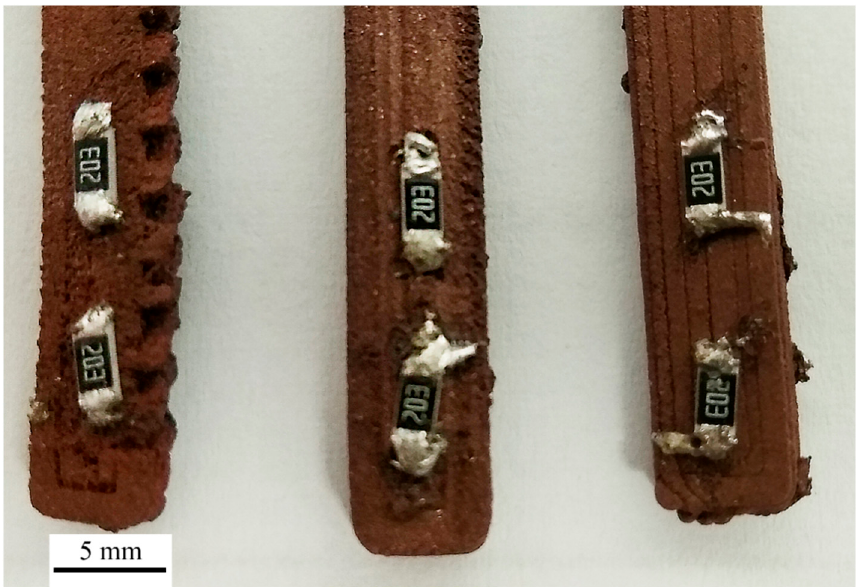
Figure 3. Soldered joints on different composites (from left: ABS/Cu, PS/Cu, PLA/Cu) fabricated with hot iron soldering method and Sn63Pb37 solder alloy.